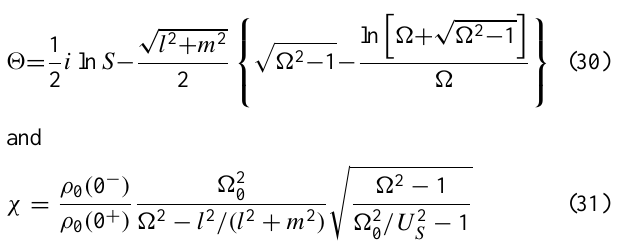
Fig. 3. Computation of fields in the neighbourhood of a turning point and a field line resonance (see text for expla- nation)